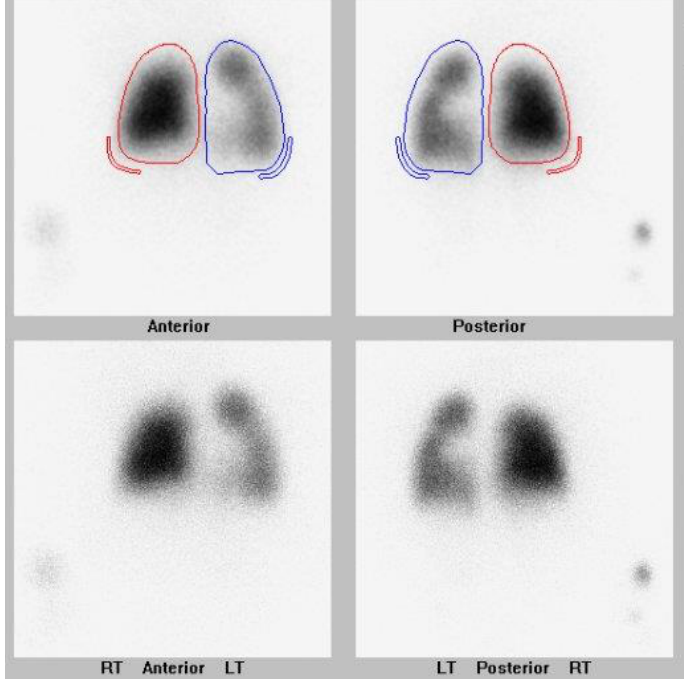
Figure 2. Most recent nuclear lung perfusion scan of patient who is now 3 years old with multivessel pulmonary vein stenosis involving all pulmonary veins. Patient has undergone 2 cardiac surgeries and 9 cardiac catheterizations on her pulmonary veins. Differential pulmonary perfusion as quan- titated based on Tc-99m MAA localization is 34% left lung and 66% right lung. There is further diminished perfusion in the left compared to the right lung. Within the right lung, there is a similar pattern of diminished perfusion in the apex relative to the remainder of the lung. Within the left lung, there is interval slightly improved relative perfusion in the upper lung, and relatively diminished perfusion in the lower lung. Right lung is outlined in red. Left lung is outlined in blue.